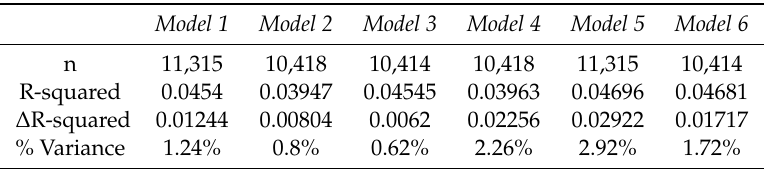
Table 2. E ff ect sizes and % variance